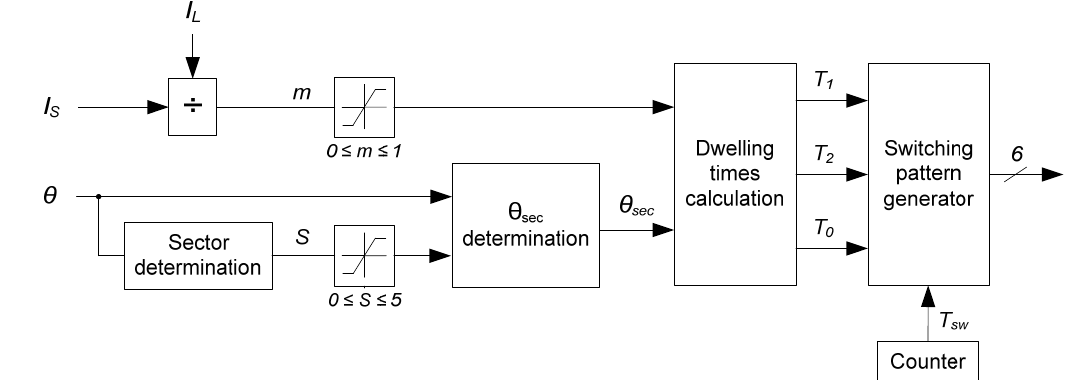
Figure 15. Scheme of the SVM modulator for a